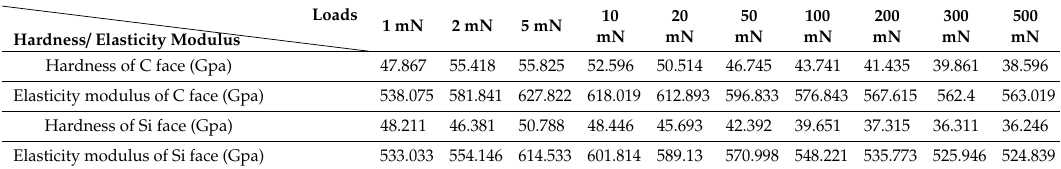
Table 2. Hardness and elastic modulus of Single crystal 6H-SiC substrates by quasi-static indentation. Hardness / Elasticity